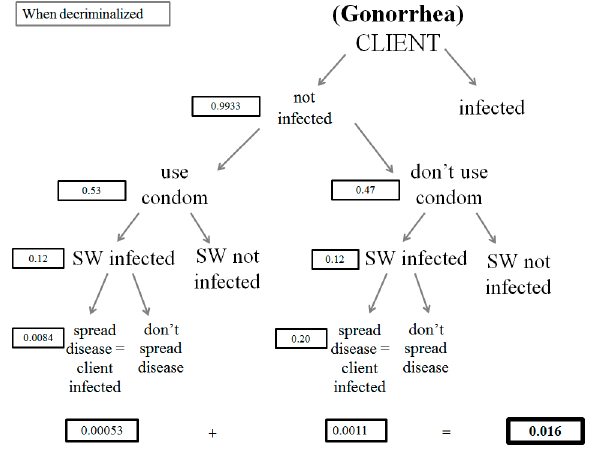
Figure A15. Risk of gonorrhea transmission to a client under decriminalization.